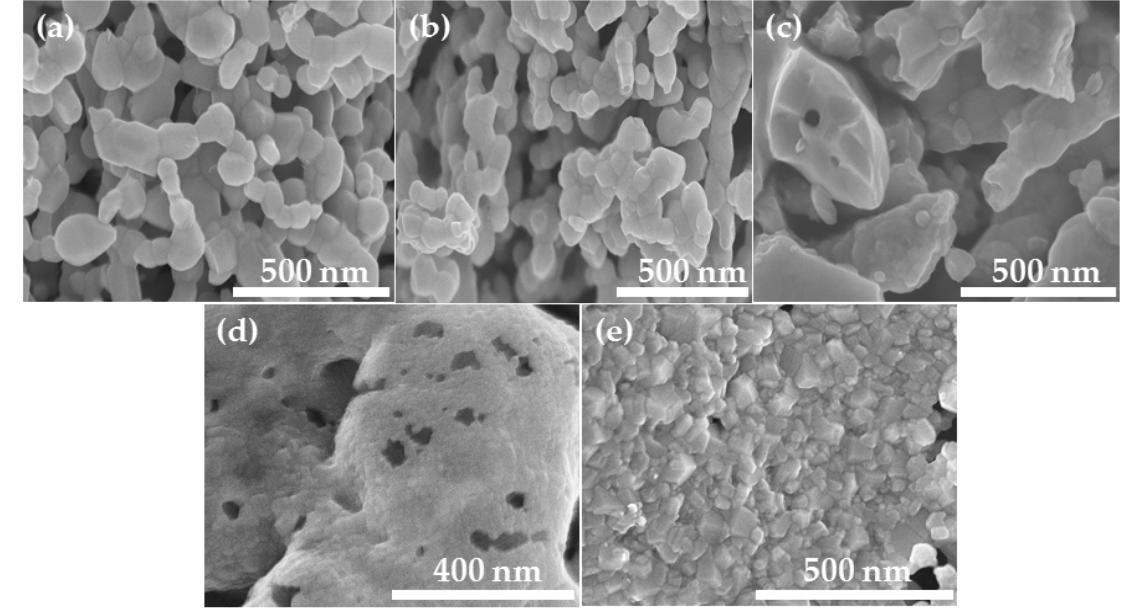
Figure 4. SEM images: ( a ) LaCoO 3 ; ( b ) LaCo 0.75 Mn 0.25 O 3 ; ( c ) LaCo 0.50 Mn 0.50 O 3 ; ( d ) LaMnO 3 ; (e) LaNiO 3 .